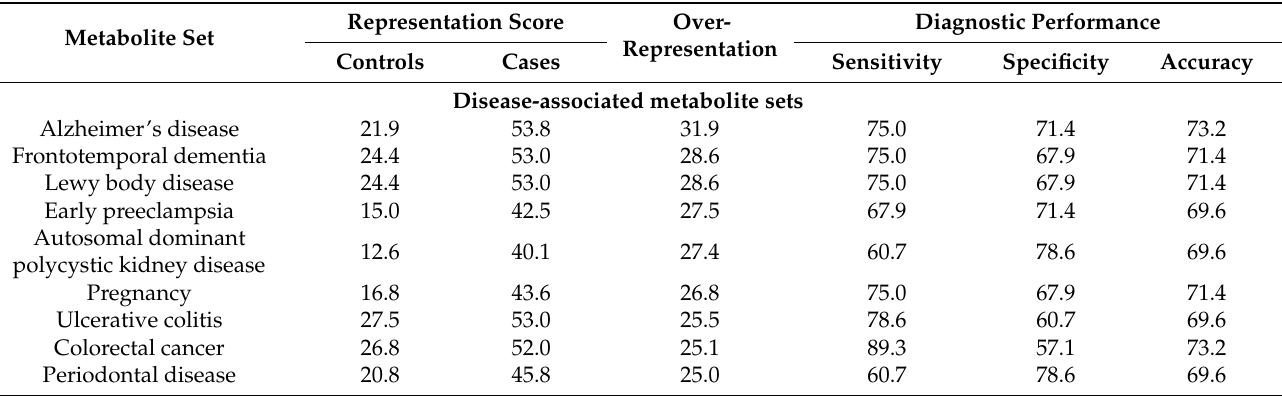
Figure 2. LDT output for the ‘case-control’ study of Parkinson’s disease (PD). The output is presented for disease-associated metabolite sets ( a ), pathway-associated metabolite sets ( b ), metabolite sets associated with abnormal concentrations of metabolites ( c ), and location-based metabolite sets ( d ). The top five overrepresented metabolite sets are colored in red. The metabolite set representation scores for the control samples, samples from PD patients, and the top 20 overrepresented metabolite sets for the PD patients are listed in Table 2. Table 2. Criteria for laboratory-developed test diagnostics for Parkinson’s disease.